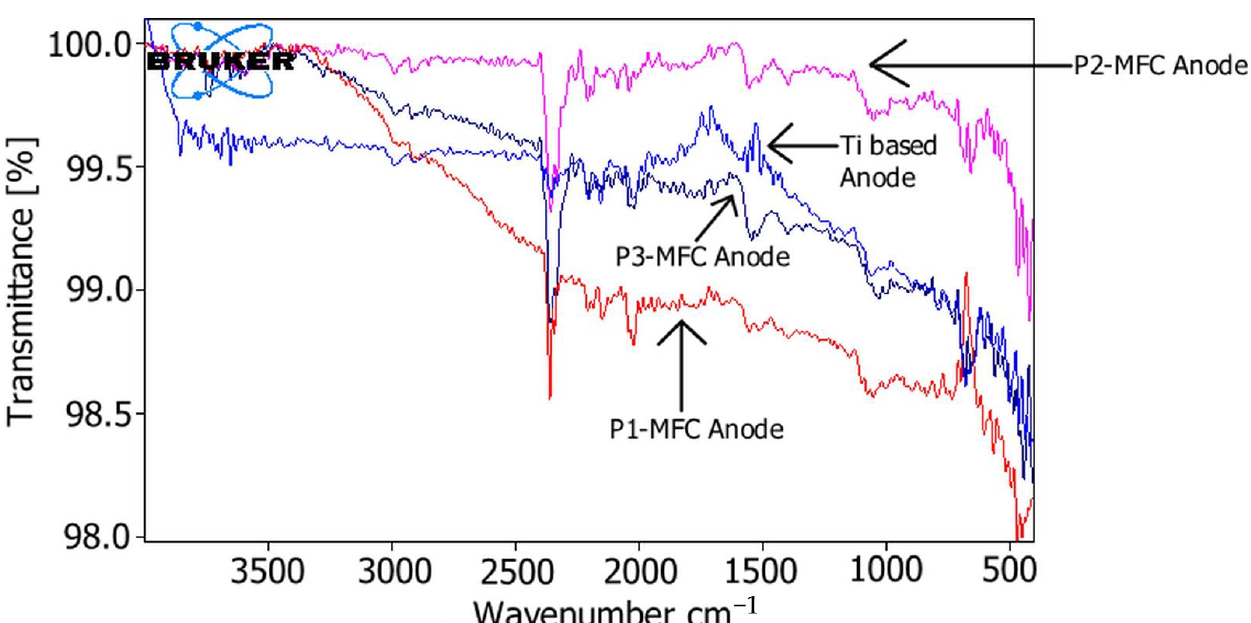
Figure 5. FTIR analyses of Ti-based anodes of MFCs.